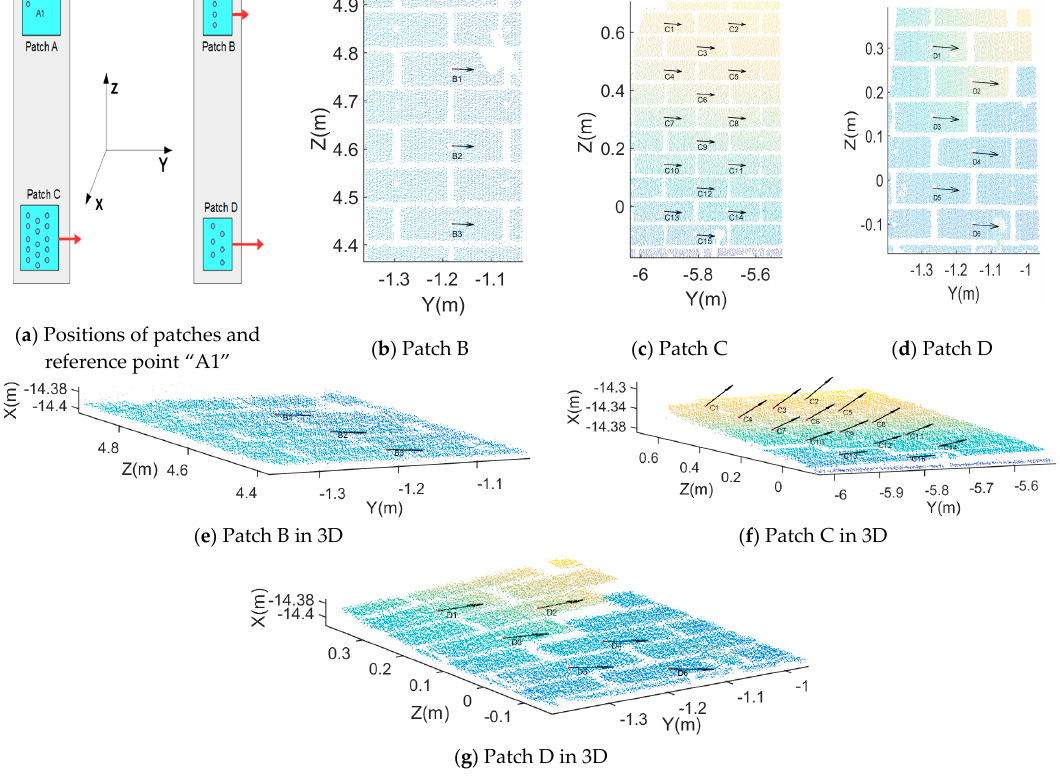
Figure 17. Displacement vectors. In the Figures ( b – d ) 2D vectors are given, indicating relative changes parallel to the affected wall. Full 3D vectors are given in Figures ( e – g ). Table 3. Displacement of baselines connected to patch A.